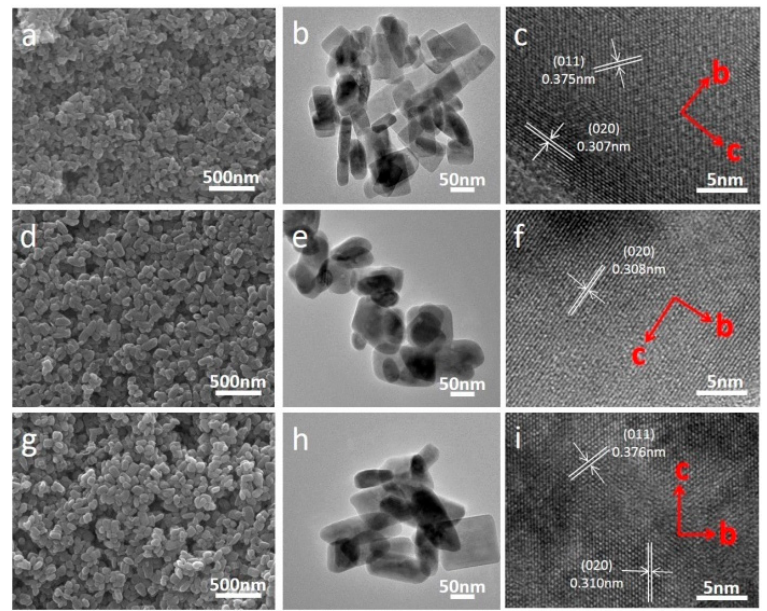
Figure 2. SEM, TEM, and FFT images of LiMn x Fe 1 − x PO 4 : ( a – c ) x = 1; ( d – f ) x = 0.4; ( g – i ) x = 0. LiMn 0.4 Fe 0.6 PO 4 /C inherits plate-like morphology and crystal growth orientation along the bc plane of the precursors. No agglomeration and particle size growth are observed.